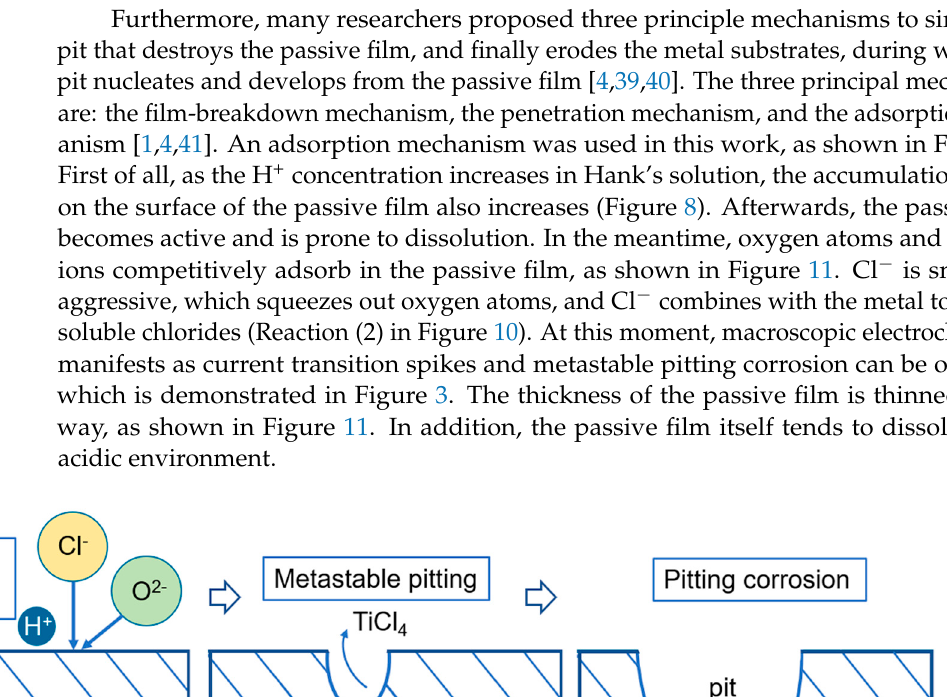
Figure 11. Diagram of the adsorption mechanism of the passive film in acidic